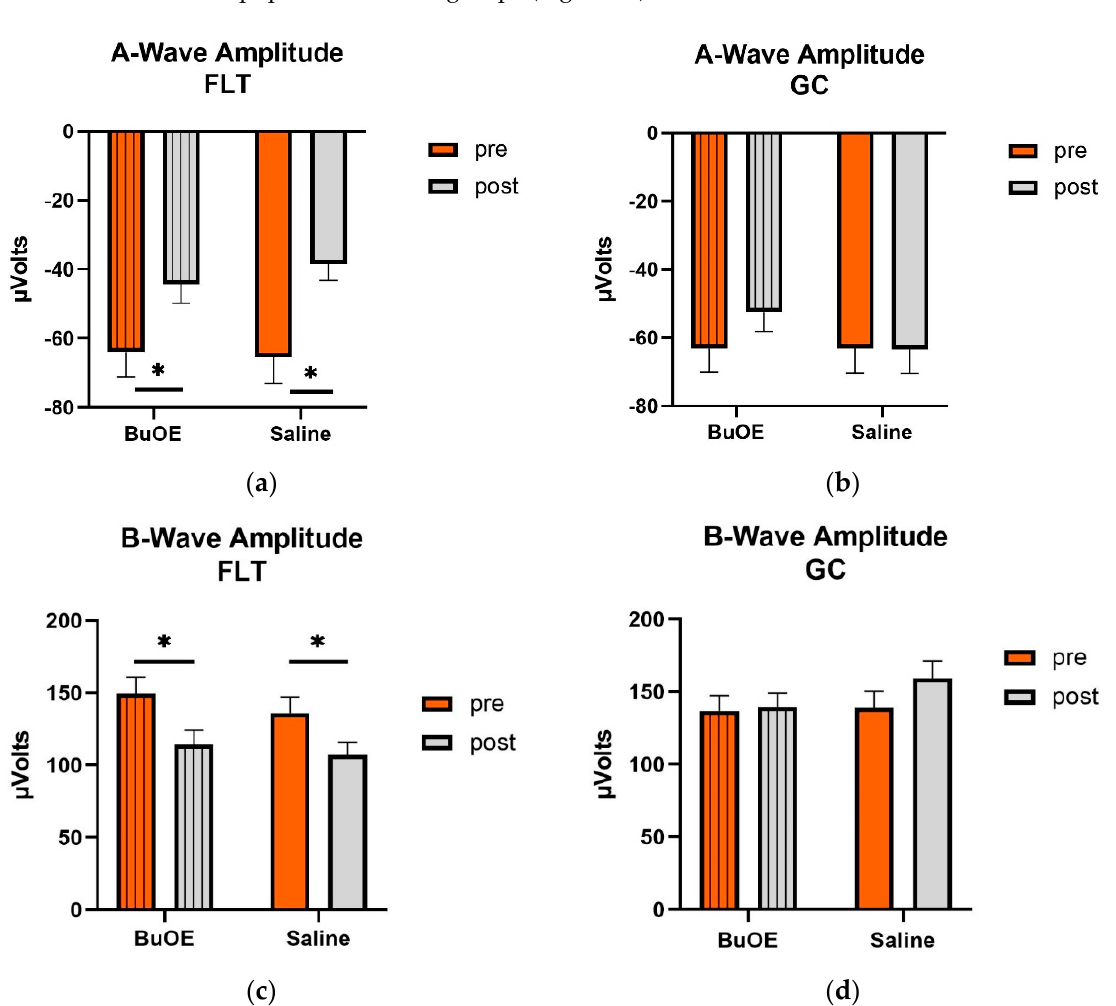
Figure 6. Pre- and post-flight comparison of the average response to the light sensitivity of the retina to the a- and b-wave in saline and BuOE-treated (FLT) and habitat control (GC) groups. The amplitudes were averaged over 8 flash strength from − 1.7 to 2.5 log cd s/m 2 . ( a ) The a-wave FLT group. * Significantly different between pre- and post-flight in both saline and BuOE groups ( p < 0.05). ( b ) The a-wave GC group. No significant difference among groups. ( c ) The b-wave FLT group. * Significantly different between pre- and post-flight in both saline and BuOE groups ( p < 0.05). ( d ) The b-wave GC group. No significant difference among groups. Bars represent the mean+ SEM (n =